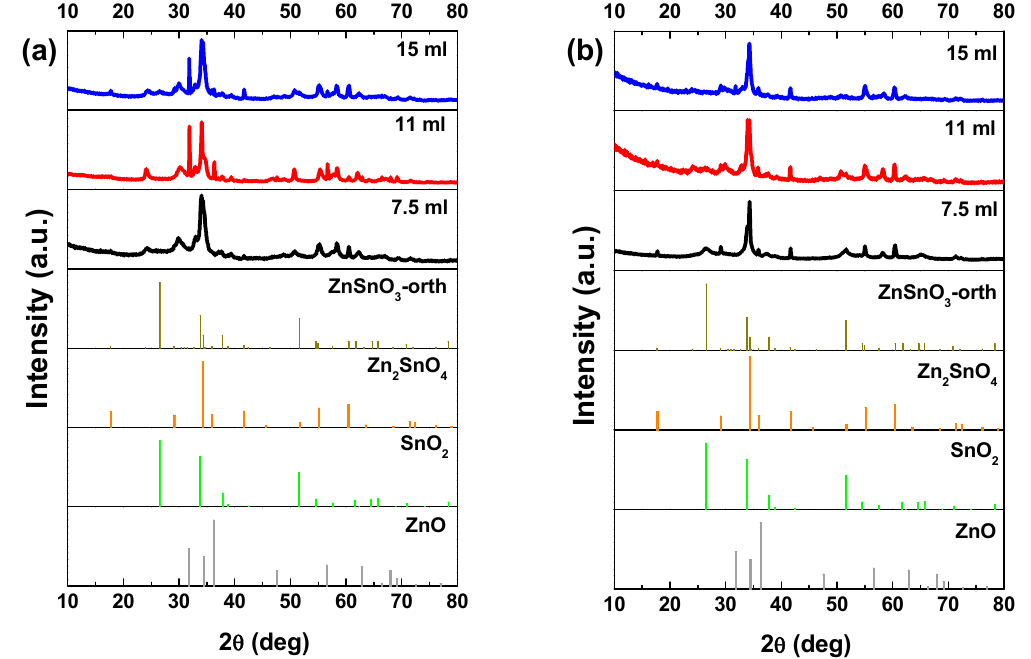
Figure 1. XRD patterns when using ( a ) ZnCl 2 precursor (with 2:1 Zn:Sn ratio) and ( b ) ZnAc precursor (with 1:1 Zn:Sn ratio), for different solution mixture volumes (7.5 mL, 11 mL, and 15 mL). Identification following ICDD card 00-028-1486 (ZnSnO 3 -orth, deleted), 00-024-1470 (Zn 2 SnO 4 ), 01- 077-0452 (SnO 2 ), and 00-06-1451 (ZnO).